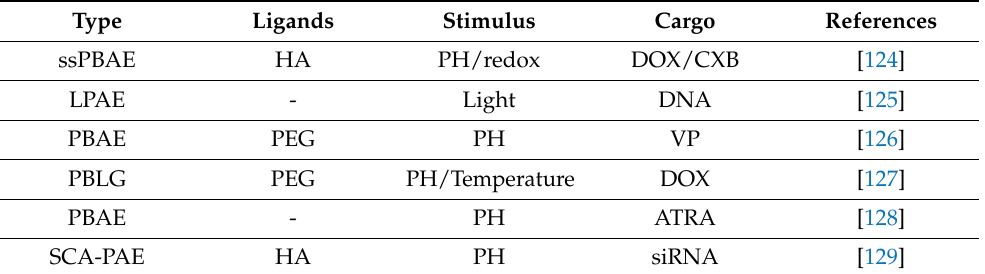
Table 4. Various responsive Amino acid derived biopolymers are used to deliver cargos.